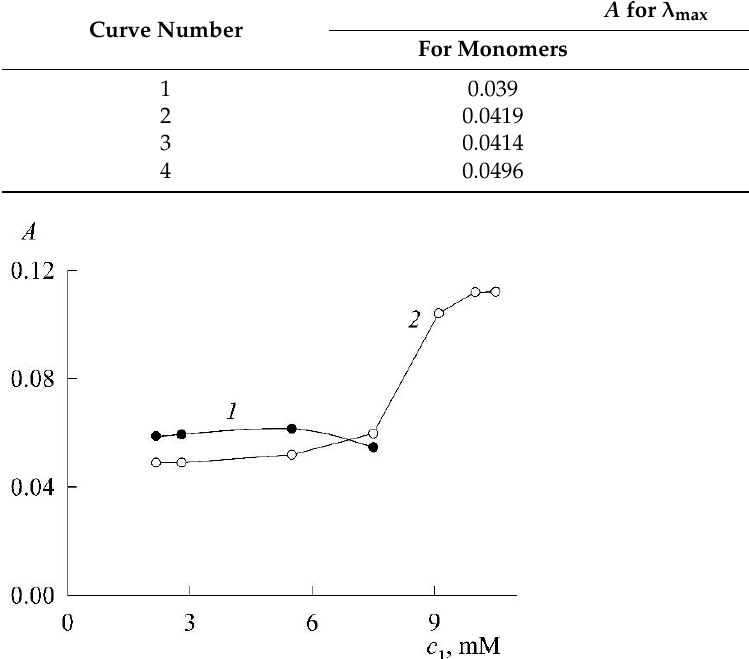
Figure 13. Function A ( c 1 ) for dimers (curve 1 ) and monomers (curve 2 ) of NR in the SDS solution at